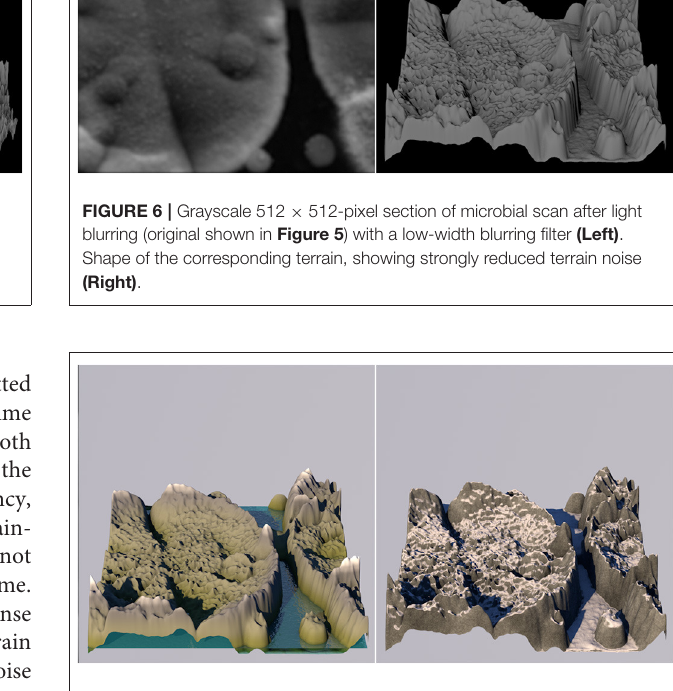
FIGURE 7 | Smoothened terrain as shown in Figure 6 , with procedurally added natural elements using very basic operations. Different colors were assigned to terrain elements based on local terrain height, and water was added (Left) . Slope angle information was used to accumulate virtual snow (Right)